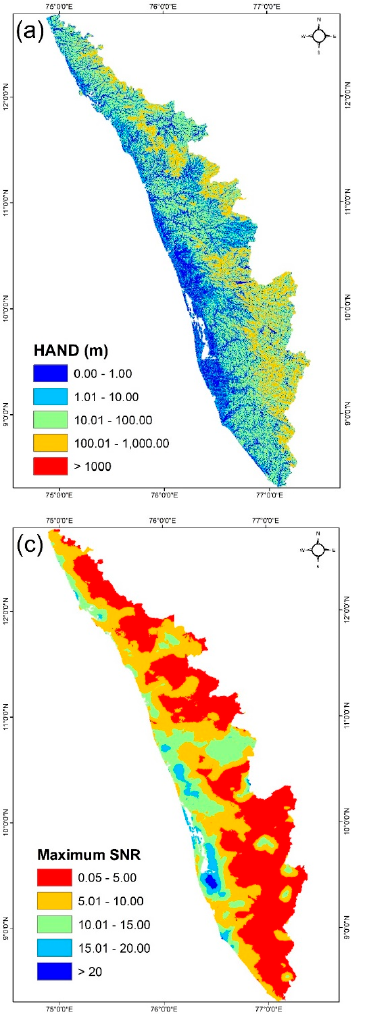
Figure 3. Case I ( a ) HAND flood terrain model for Kerala; ( b ) SND obtained for Kerala; ( c ) maximum SNR obtained from the Cyclone Global Navigation Satellite System (CYGNSS) for August 2018; ( d ) proposed model output for Kerala during floods of August 2018.